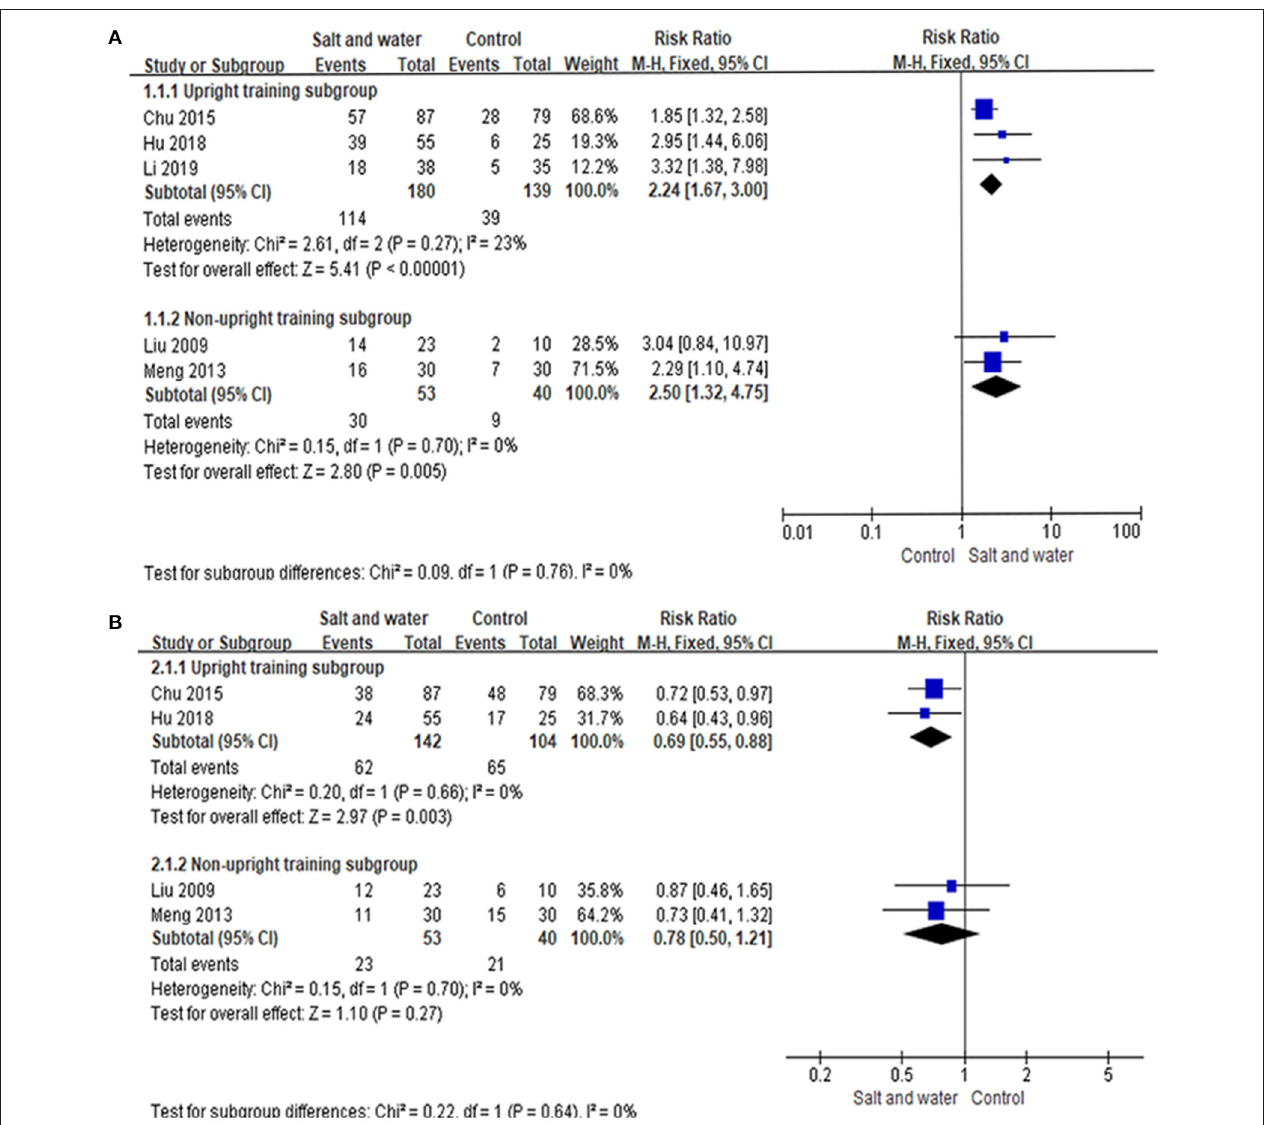
FIGURE 5 | Forest plot of the subgroup analysis. (A) Forest plot of the studies evaluating the therapeutic efficacy of different subgroup with the negative changing rate of HUTT. (B) Forest plot of the studies evaluating the therapeutic efficacy of different subgroup with the syncope or presyncope recurrence rate. Heterogeneity analysis showed no conspicuous heterogeneity among the above studies, and a fixed-effect model was adopted. The RR results analyzed by the M-H test are summarized on the right. The RR and its 95% CI of each study are represented by small squares and transverse lines, respectively, and the rhombus below represents the overall results of the meta-analysis. RR, risk ratio; CI, confidence interval; M-H, Mantel-Haenszel